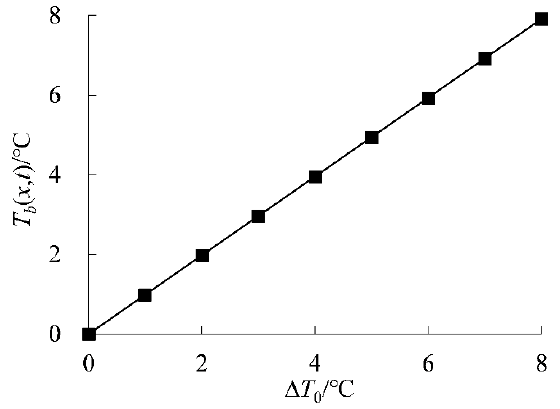
Figure 10. The relationship between T b ( x , t ) and ∆ T 0 .